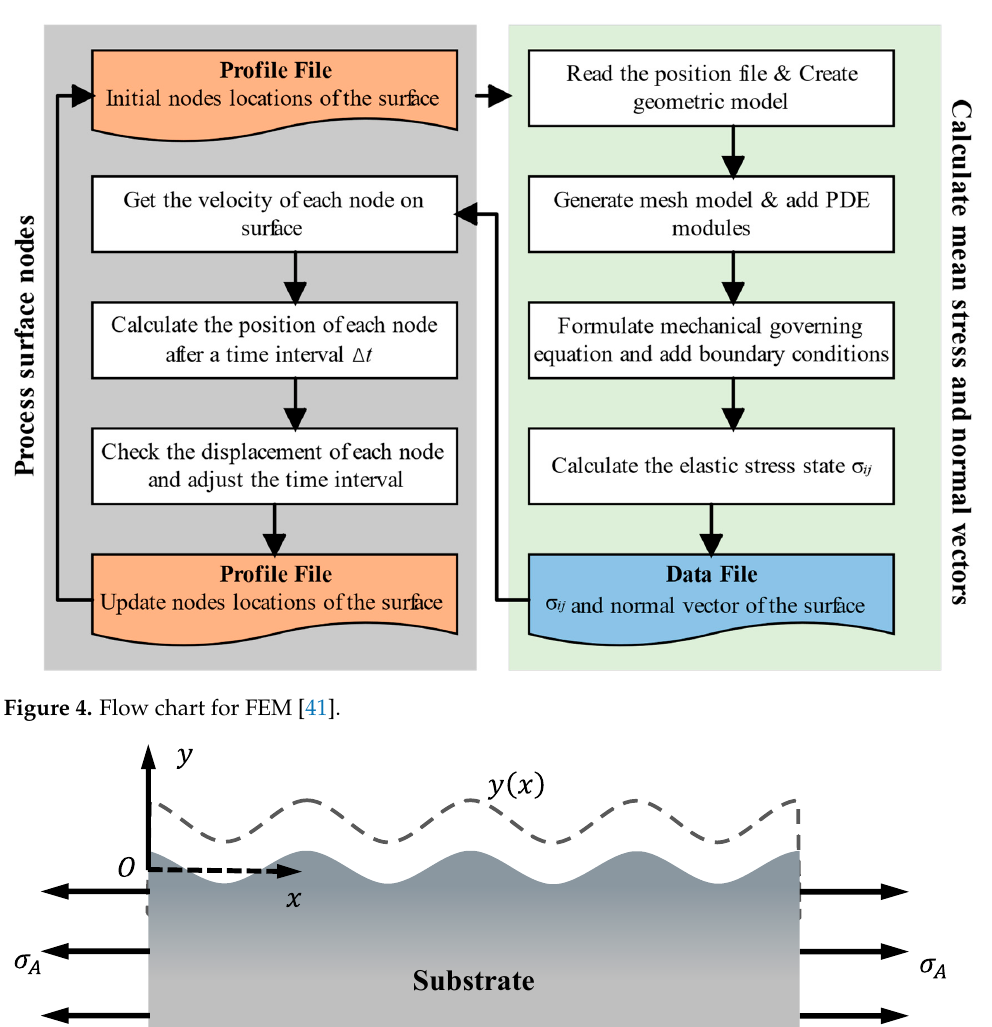
Figure 5. A semi-infinite elastic substrate with a sinusoidal surface profile, which is evolving under stress corrosion.